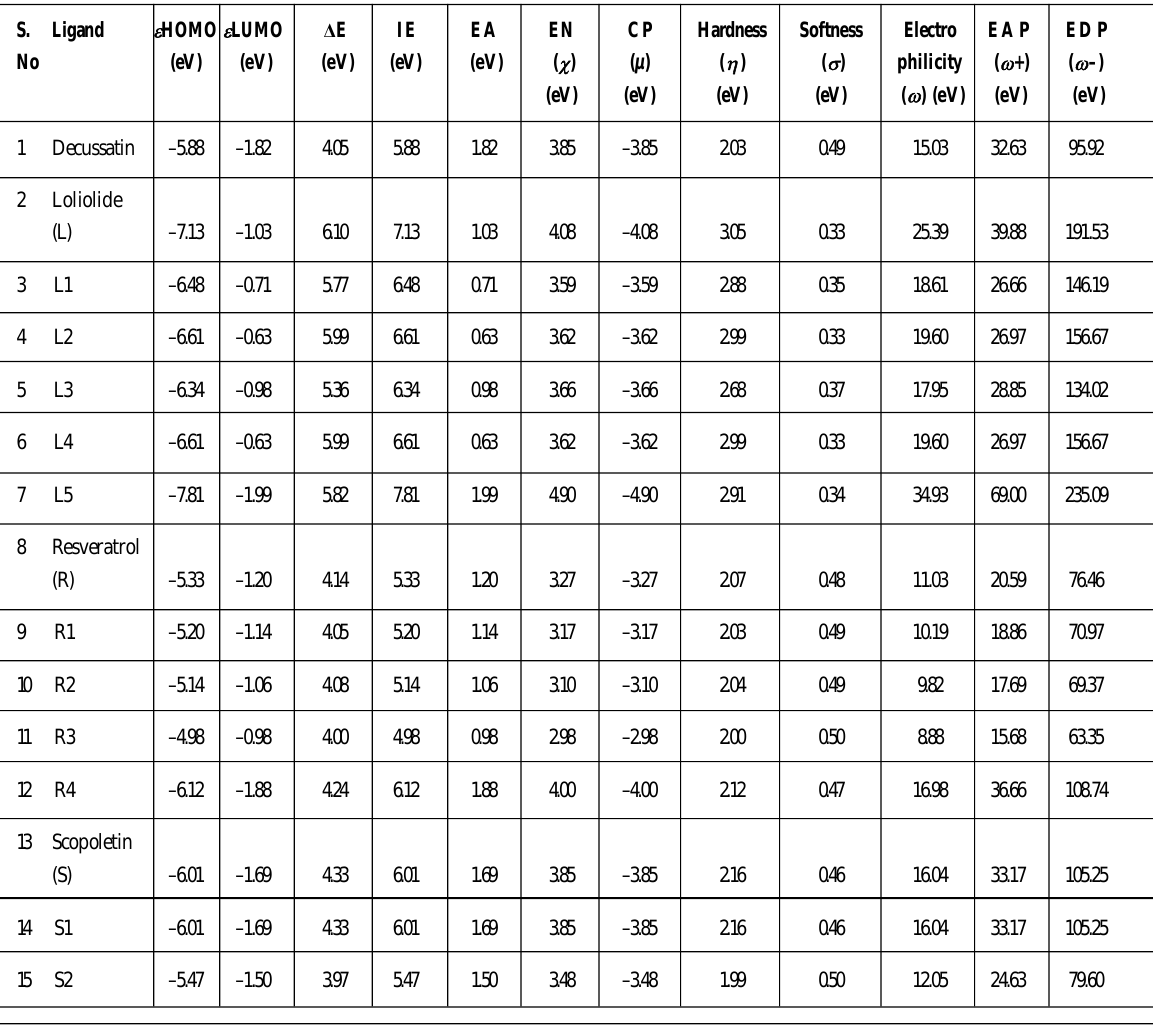
Table 2. The quantum reactivity parameters (eV) computed for the ligand library based on Koopman’s theorem and Parr and Pearson’s interpretation (IE: Ionization Energy; EA: Electron Affinity; EN: Electronegativity; CP: Chemical Potential; EAP: Electron Accepting Power; EDP: Electron Donating Power)